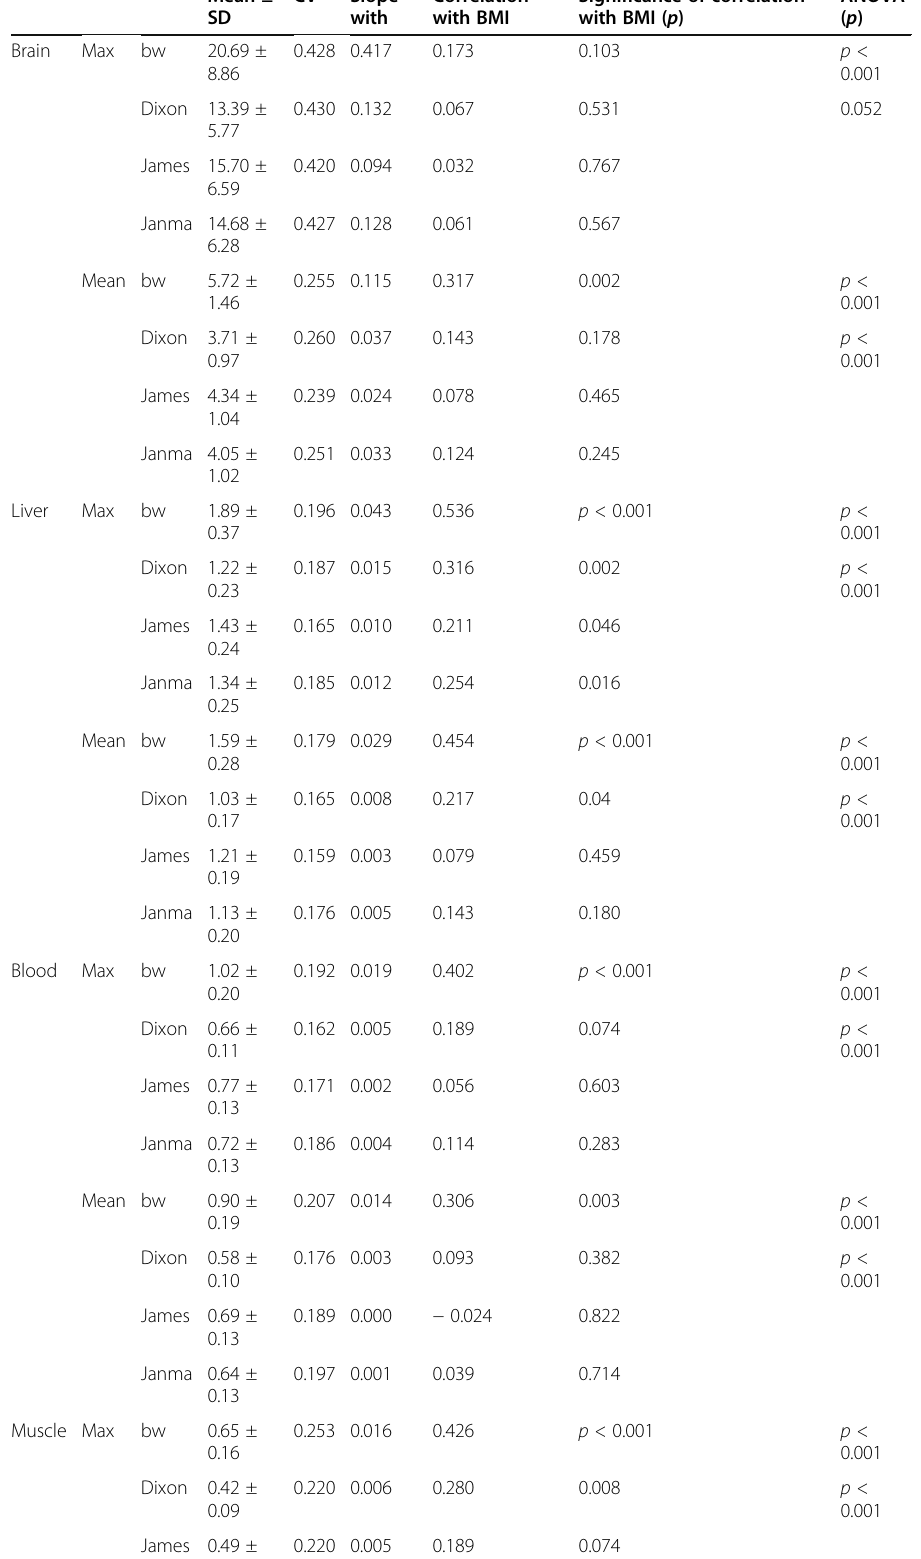
Table 3 Fitting results and dependent analysis of SUV vs. BMI for the FDG study ( n =